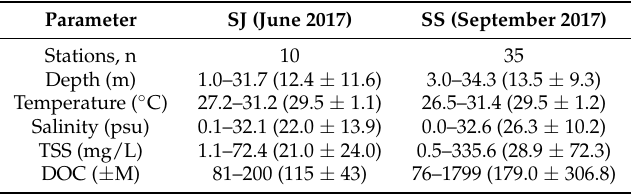
Table 1. Overview of physical and biogeochemical parameters in surface waters during June and September 2017 field campaigns, these data are reproduce from Martin et al. [27]. Minimum, maximum, and mean ( ± standard deviation) are